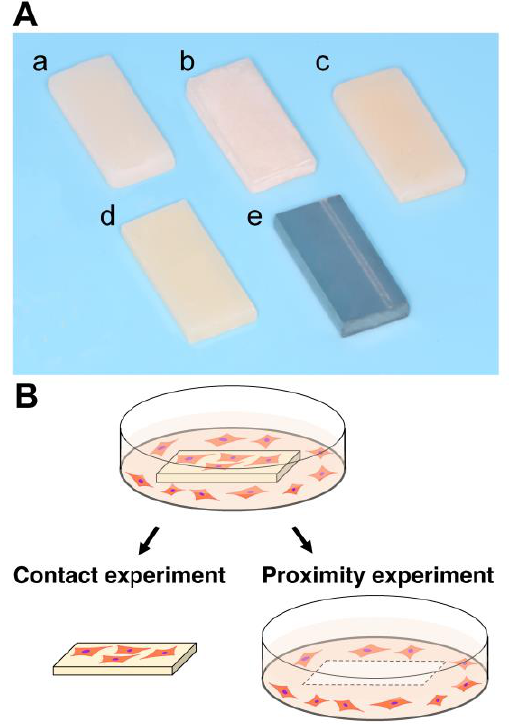
Figure 9. ( A ) Test specimens made of bis-acrylic ( a ), flowable composite ( b ), bulk-fill composite ( c ), self-curing acrylic ( d ), and grade 5 titanium alloy ( e ). ( B ) Culture experiment design. The